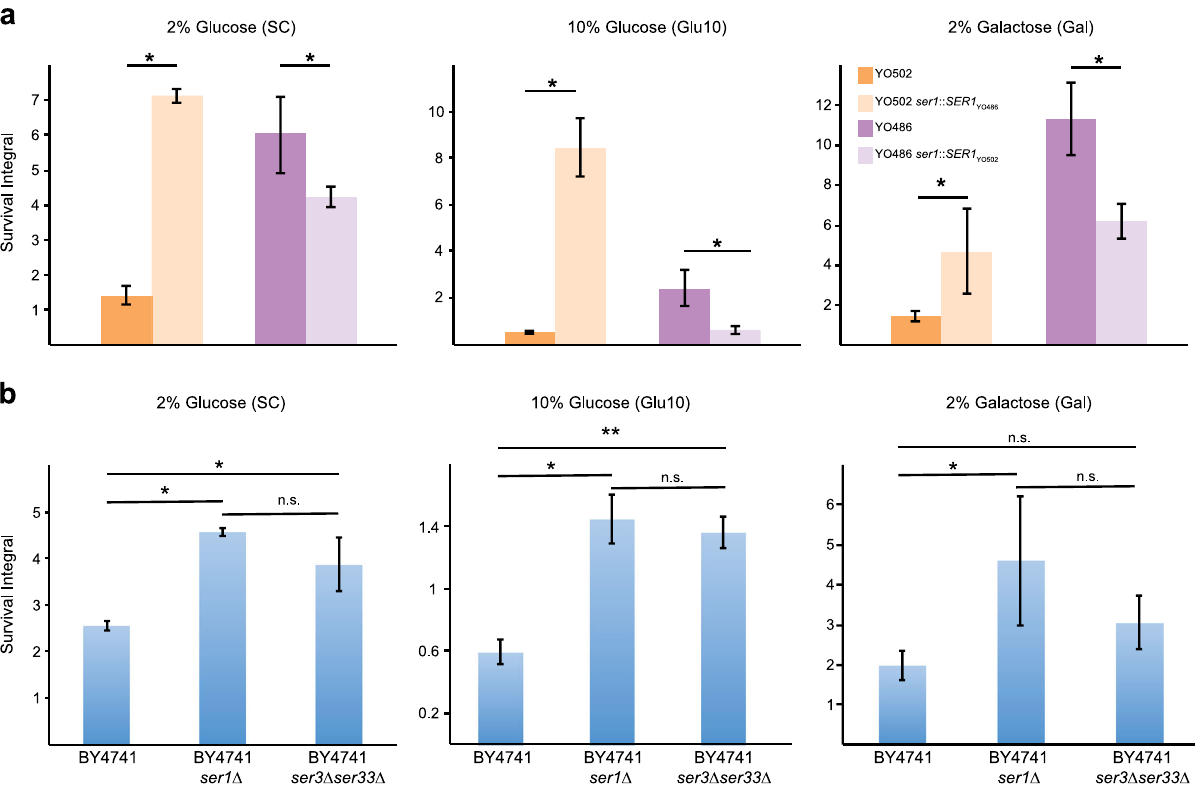
Fig. 5 Validation of SER1 as an aging gene. a Survival integrals for allele-swapped strains were determined using an outgrowth kinetics assay for the indicated strains in SC medium containing 2% glucose, 2% galactose, and 10% glucose. b Survival integrals for ser1 Δ and ser3 Δ ser33 Δ deletion mutants and the isogenic BY4741 strain. Results correspond to mean ± SDs for three biological replicates. n.s. not signi fi cantly different; * p < 0.05; ** p < 0.005 according to Student ’ s t